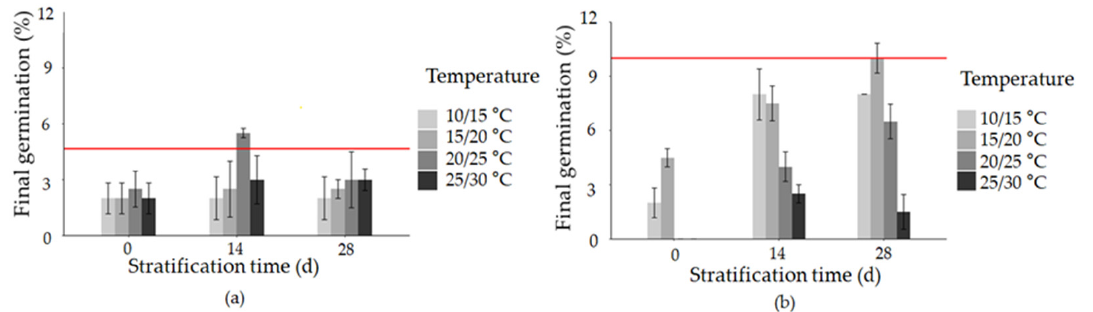
Figure 3. Variation in the final germination percentage of Abies beshanzuensis ( a ) and Abies ziyuanensis ( b ) under different treatments (mean ± SE). Red solid lines represent seed vigor as measured by a tetrazolium test. The bar is not visible for treatments with no seed